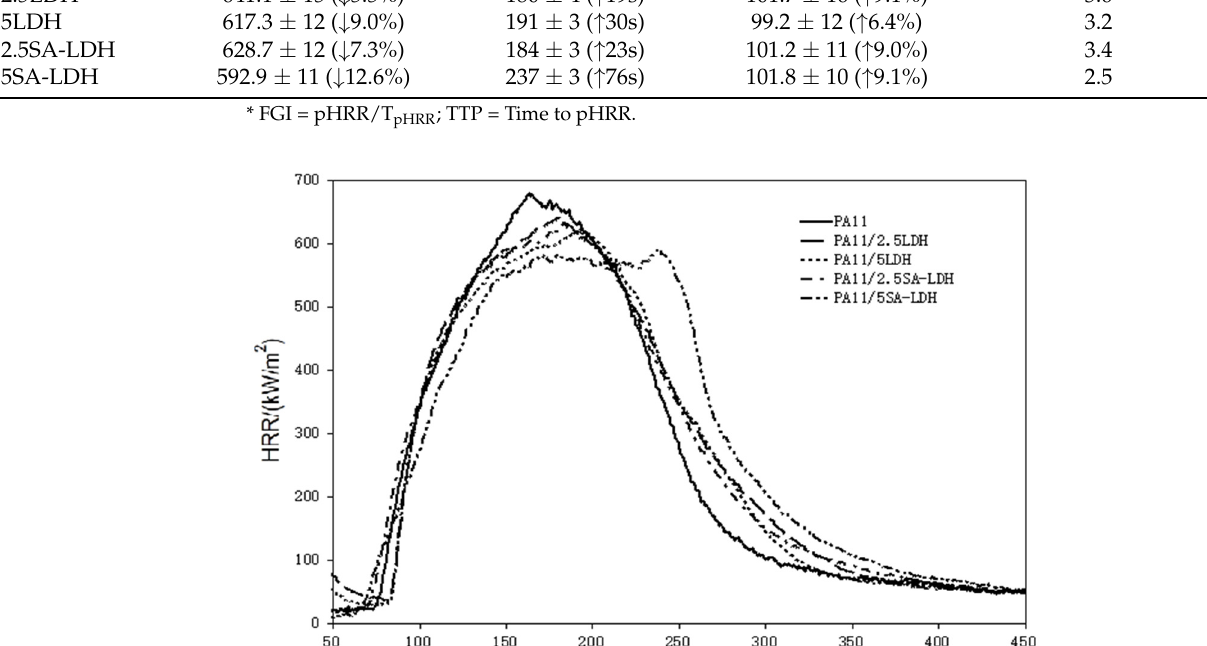
Table 3. Some key results for PA11 composites of CCT.